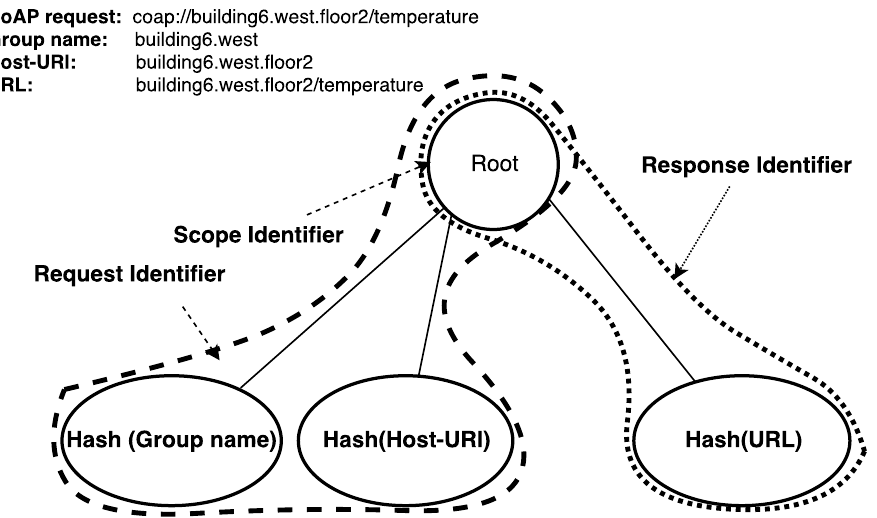
Figure 3. Namespaces for in the POINT